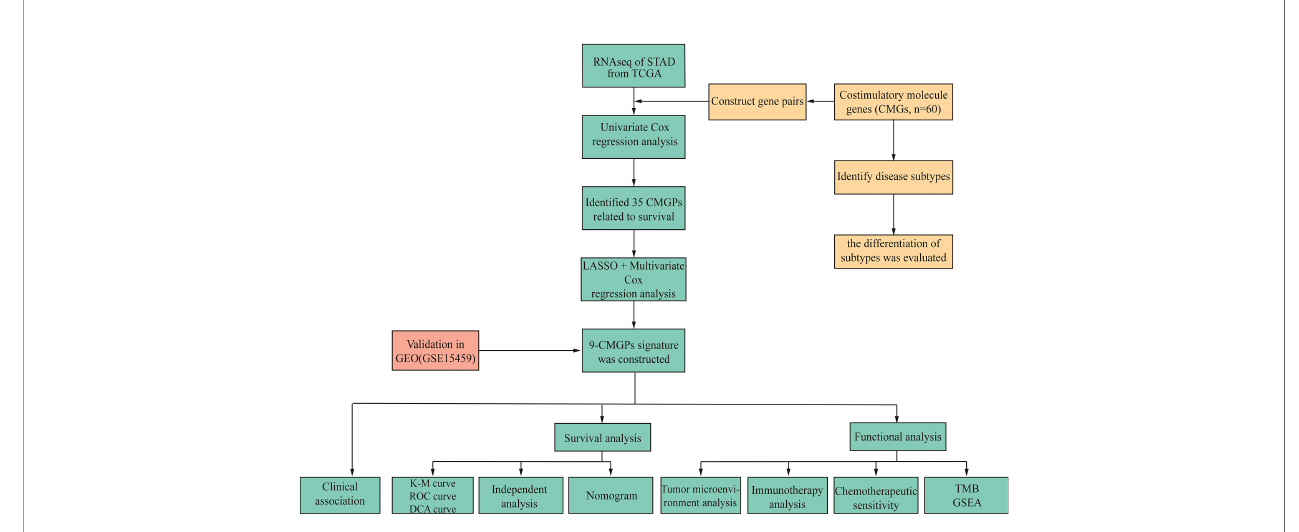
FIGURE 1 | Flowchart of the data